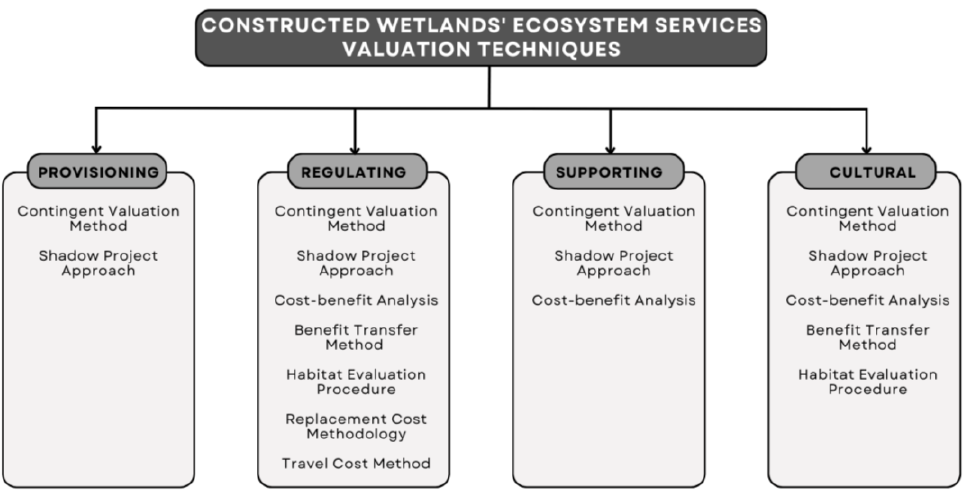
Figure 3. Summary of ecosystem service valuation techniques for constructed wetlands.